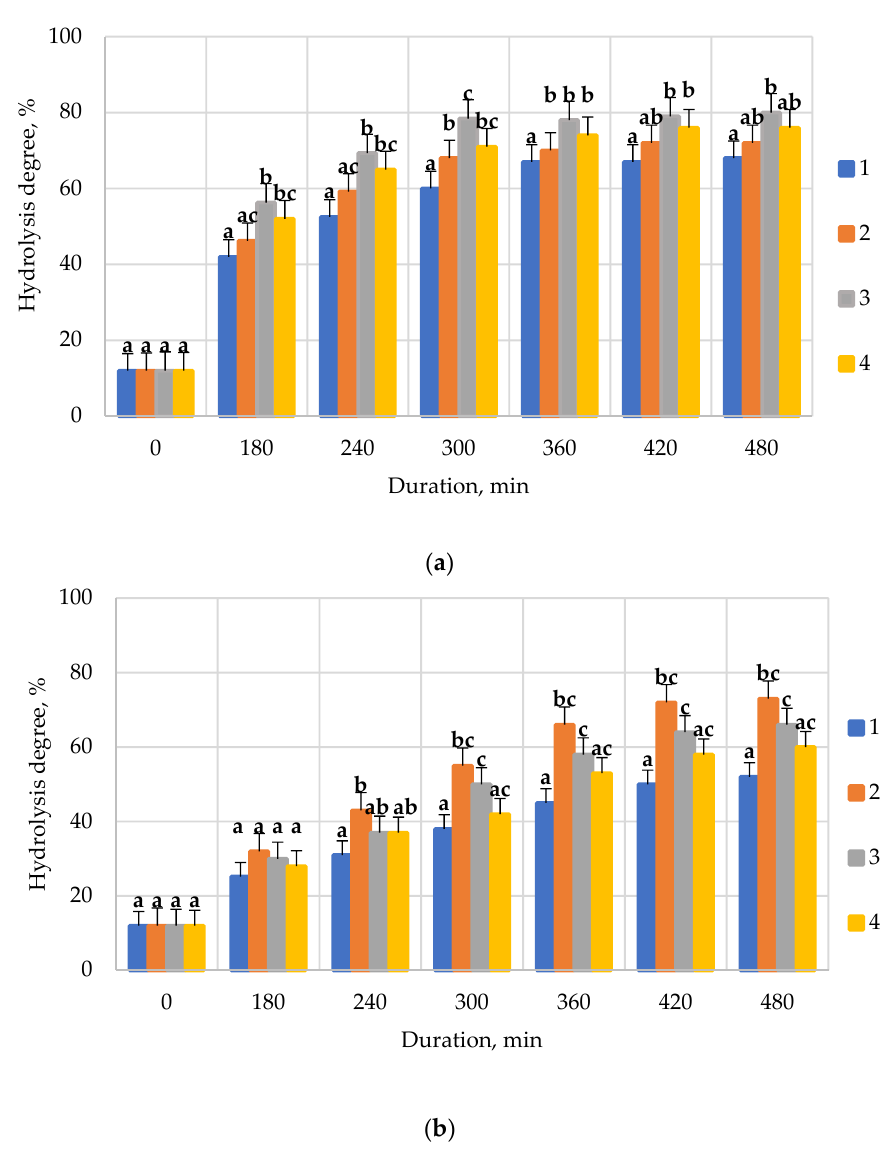
Figure 2. Results of studying the biodegradation of protein molecules in samples of collagen-containing raw materials by ( a ) collagenase or ( b ) Neutrase 1.5 MG at different pH values: 1–5.0; 2–6.0; 3–7.0; 4–8.0. Values followed by the same letter do not differ significantly ( p > 0.05) as assessed by post hoc test (Tukey test). Table 1. Generalized results on selecting parameters and substantiation of technological modes of biodegradation of collagen-containing waste by enzyme